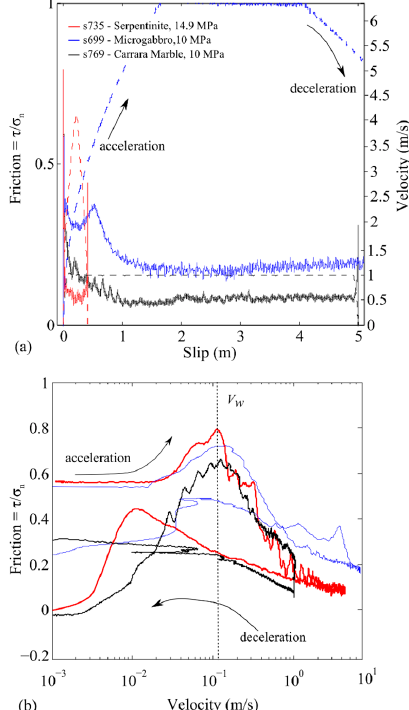
Figure 1. Frictional evolution of rocks in high velocity experiments simulating the passage of the rupture front at point of a fault during an earthquake. The experiments were performed with the rotary shear machine SHIVA. Samples were sheared at ambient conditions under a constant normal stress of σ n = 10 MPa and at seismic slip rates (>1 m/s). ( a ) Friction coefficient evolution with slip of cohesive Carrara marble (99.9% calcite, s769), microgabbro (main mineral plagioclase, s699), and serpentinite (main mineral antigorite, s735) resulting from high-velocity friction experiments. The slip rate of the applied velocity ramp (dashed lines) is on the right y-axis; ( b ) Friction evolution with slip rate for the same experiments reported in Figure 1a. The critical velocity V w at the onset of the large dynamic weakening was 0.103 ± 0.03 m/s.